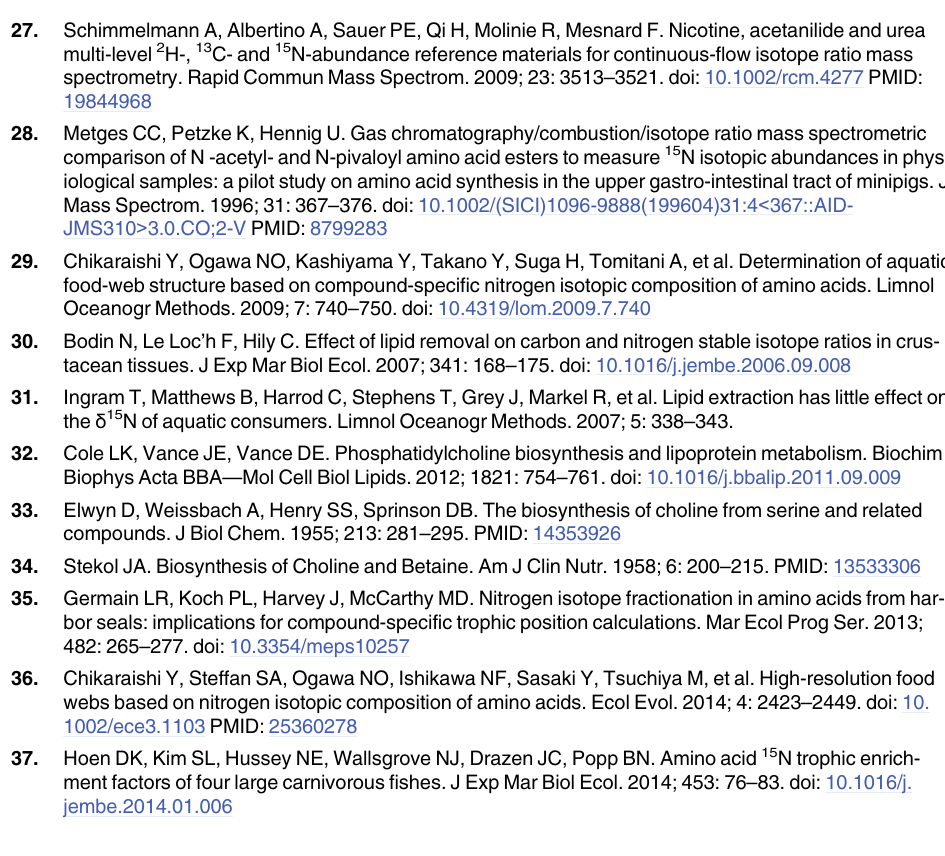
PLOS ONE | DOI:10.1371/journal.pone.0146321 January 5,